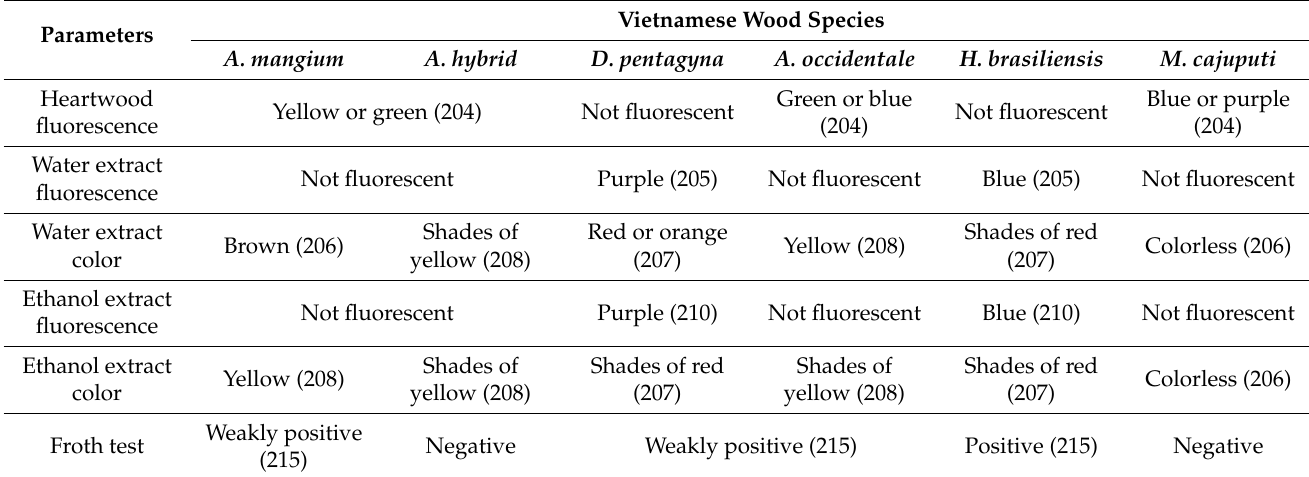
Table 3. Non-anatomical characteristics of Vietnamese wood species based on IAWA feature